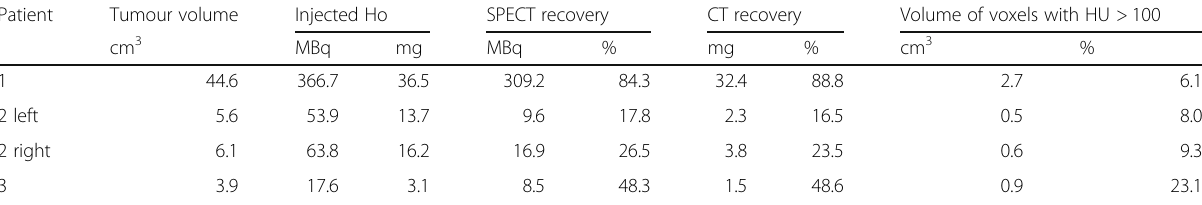
Three patients with recurrent head and neck cancer were treated with radioactive 166 Ho-microspheres and underwent SPECT/CT imaging. Patient 2 was treated on both sides of the neck. Base on the injected activity, the corresponding amount of mg Ho was calculated. Injected activity compared to SPECT recovery was 17.8 – 84.3%. CT recovery was in line with SPECT imaging ranging from 16.5 to 88.8%. Tumour volume was 3.9 – 44.6cm 3 based on the >100 HU threshold; from 6.1 to 23.1% of tumour volume was filled with 166